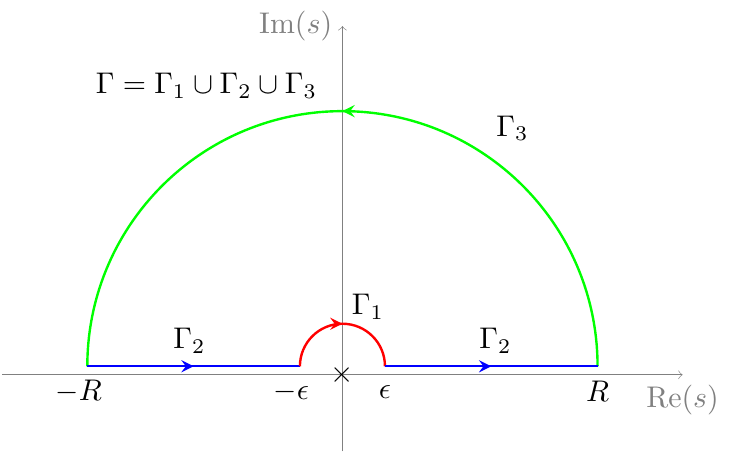
Figure 1 . The integration contour Γ = Γ 1 ∪ Γ 2 ∪ Γ 3 for the dispersion argument. Here the limits (cid:15) → 0 and R → ∞ are